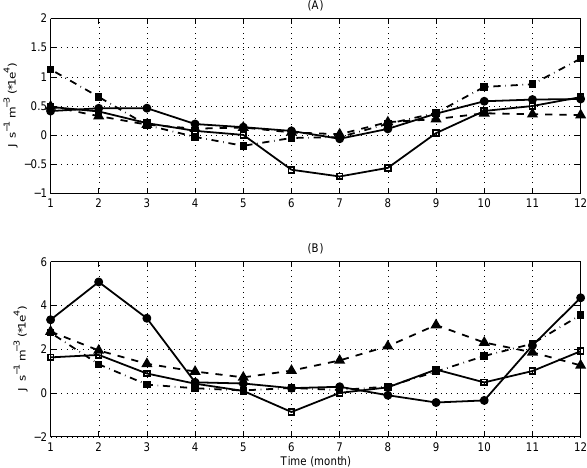
Fig. 14. Monthly time series of BEC for the Sardinia – Tyrrhenian (solid line and circle), Sicily Channel (solid line and empty square), Tunisian (dashed-dotted line and full squares) and Libyan (dashed line and triangles) sub-regions, as reported in Fig. 1, averaged on the period 2008–2010 and vertically integrated from the surface to 5m depth (panel A ) and from 5 to 80m depth (panel B ). Unit are Js − 1 m − 3 . The multiplication factor is 10 4